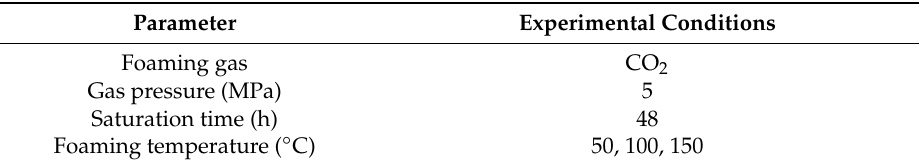
Table 4. Batch-process conditions with di ff erent foaming